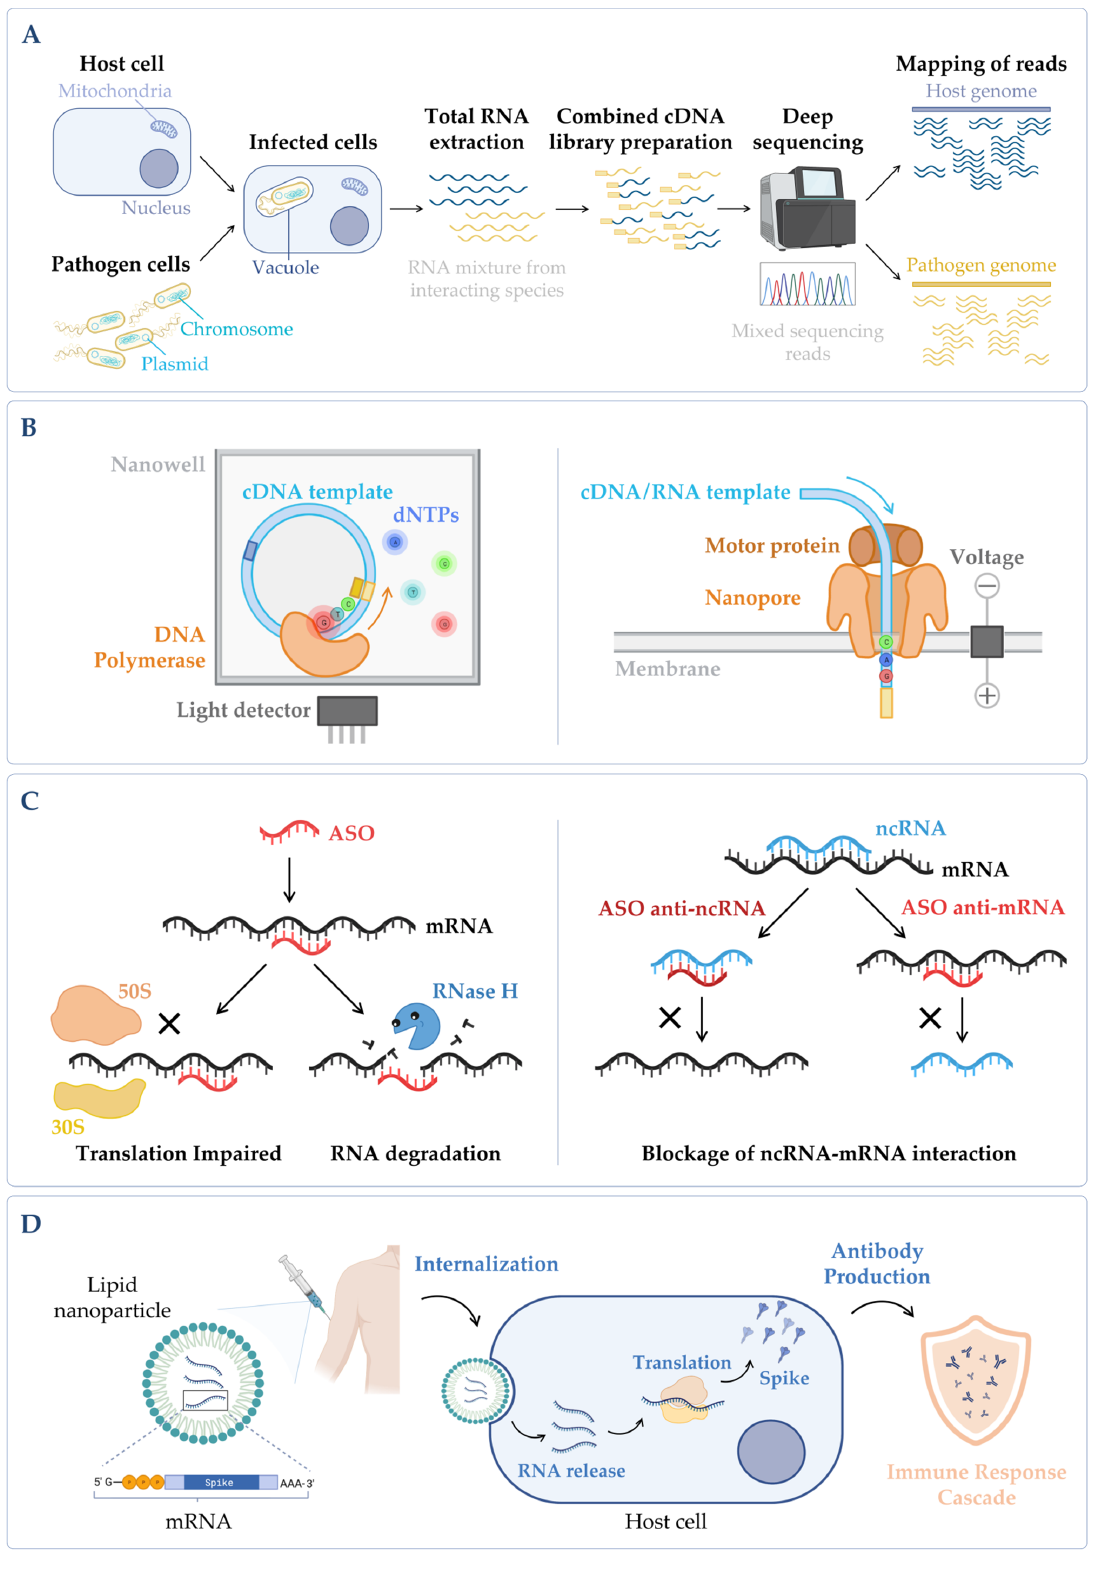
Figure 4. ( A ) Simplified workflow of a dual RNA-seq protocol . Host cells are infected in vitro with pathogen cells, lysed and total RNA is extracted. The sequencing library is prepared, and sequencing is performed in a NGS platform, obtaining simultaneously the results for both species. During